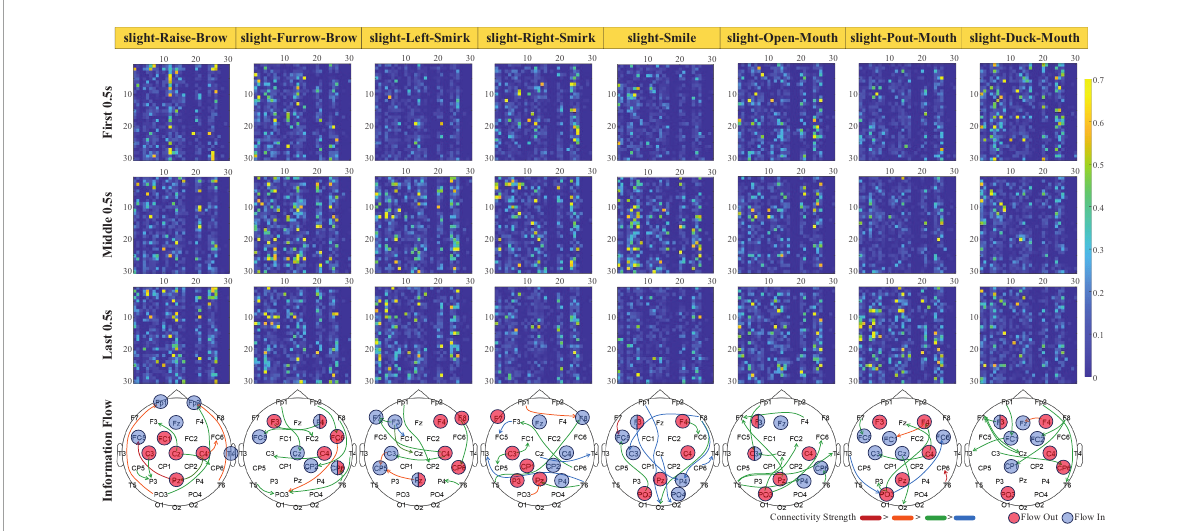
FIGURE9 The dynamic change of normalized subjects-averaged generalized orthogonalized partial directed coherence (gOPDC) during slight-facial expression (sFE), and the directed information flow with 90% percentile connectivity and channels with more interaction. The list of Channel ID.1 to ID.30 is the same as in Figure 8 , and the blocks in i th row and j th column represent the gOPDC from Channel ID. j to Channel ID. i .